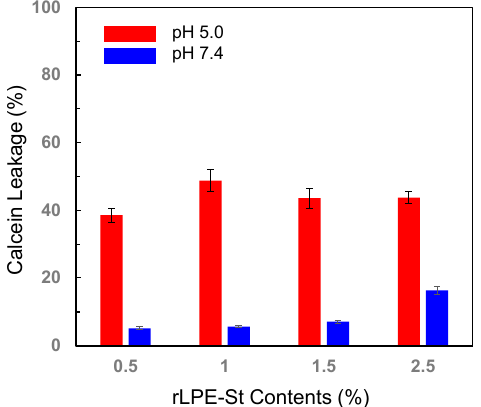
Figure 5. Percent calcein release over 40 min from 0.5, 1.0, 1.5 and 2.0 mol% rLPE-St anchoring liposomes triggered with switching the pH from 10.0 to 5.0 or 7.4. Error bars: SD of data from 5 measurements.